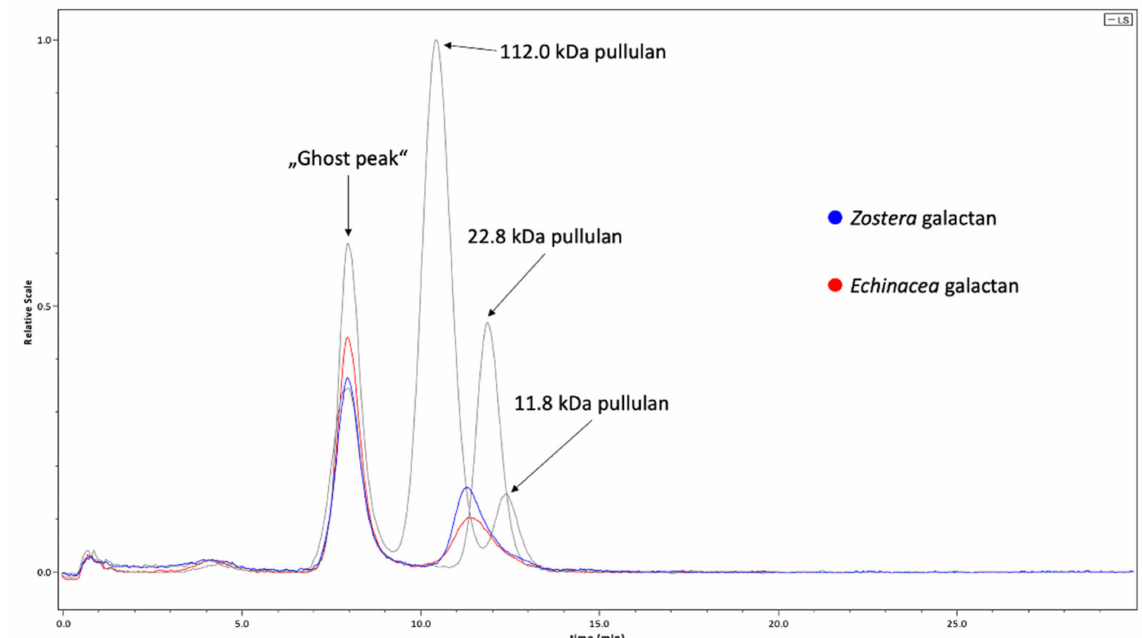
Figure 2. Gel-permeation chromatograms showing MALLS signals of Zostera galactan (blue) and Echinacea galactan (red) in comparison to standard pullulans with molecular weights of 112, 22.8 and 11.8 kDa. At the beginning of all runs, a ghost peak appears (explanation see text